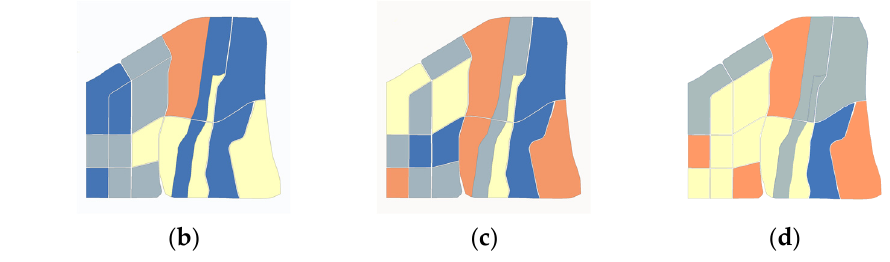
Figure 11. Optimized landscape index. ( a ) LSI. ( b ) C. ( c ) SHDI. ( d ) Den.